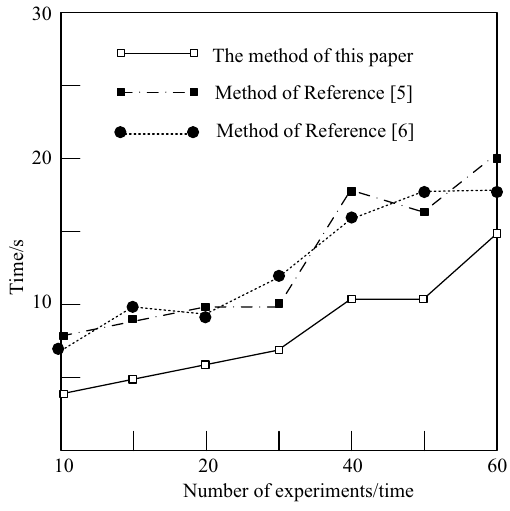
Figure 5: Comparison results of reconstruction